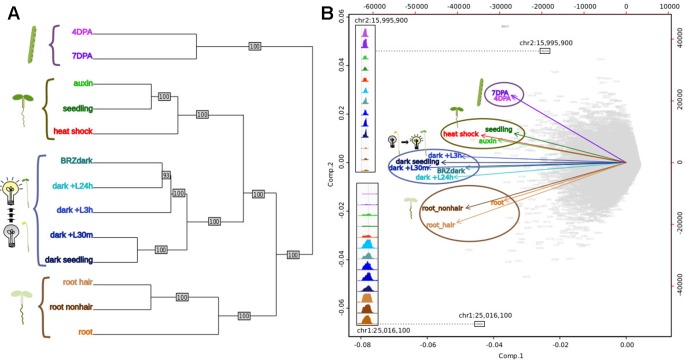
Comparative analysis of DNase I-hypersensitive site (DHS) landscapes in diverse samples. (A) Dendrogram of thirteen samples using DNase I accessibility data. 4 DPA, 7 DPA denotes seed coat-enriched samples; auxin denotes 7-day-old seedlings treated with auxin (SRR8903039); seedling denotes 7-day-old control seedlings (Sullivan et al., 2014); heat shock denotes 7-day-old seedlings treated with heat shock (Sullivan et al., 2014); BRZ denotes 7-day-old seedlings treated with brassinazole (SRR8903038); dark+L24h, dark+L3h, dark+L30m denote 7-day-old seedlings which were grown in the dark and exposed to a long-day light cycle for the indicated amount of time, modeling development during photomorphogenesis (h, hours; m, minutes) (GSM1289351, GSM1289355, GSM1289353, respectively) (Sullivan et al., 2014); dark seedling denotes 7-day-old dark grown seedlings (GSM1289357) (Sullivan et al., 2014); root hair denotes root hair cell samples of 7-day old seedlings (SRR8903037); root nonhair denotes nonhair root cells of 7-day-old seedlings (GSM1821072) (Sullivan et al., 2014); root denotes whole root tissue (GSM1289374) (Sullivan et al., 2014). (B) Biplot of principal component analysis of 62,729 DHSs by 13-sample matrix. Numbers in gray represent union DHSs. Insets show dynamic accessibility for two DHSs that were highly informative for distinguishing the 13 samples (i.e. these DHSs were among the most differentially accessible across all 13 samples). The upper inset shows a DHS that appears to be specific to aerial tissue; the lower inset shows a DHSs that appears to be specific to dark-grown tissue as roots are typically not exposed to light.